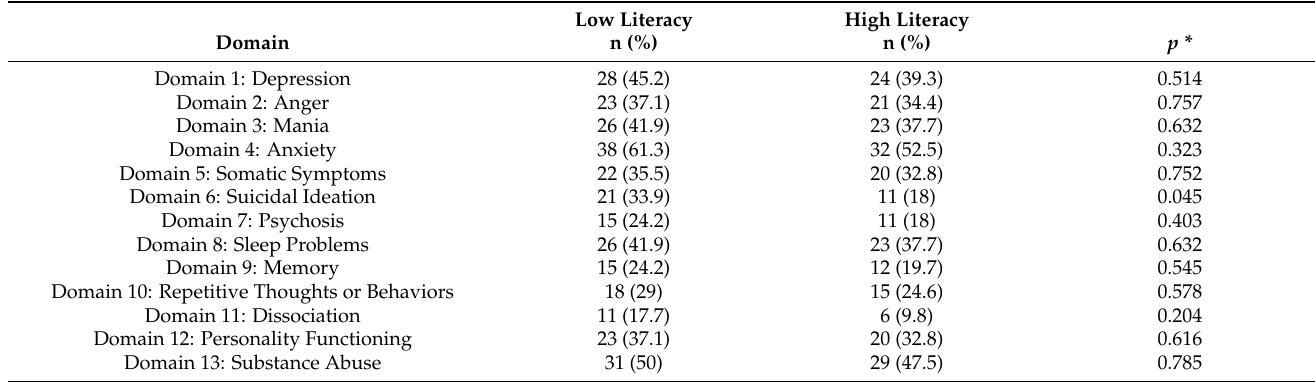
Table 5. Risk of Diagnosis by low and high